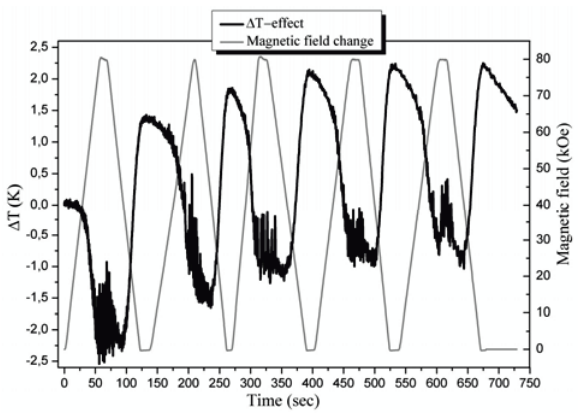
Figure 6. The time dependence of magnetic field change (gray curve) and the corresponding ∆T (black curve) of the sample at adiabatic conditions. Initial temperature is 273